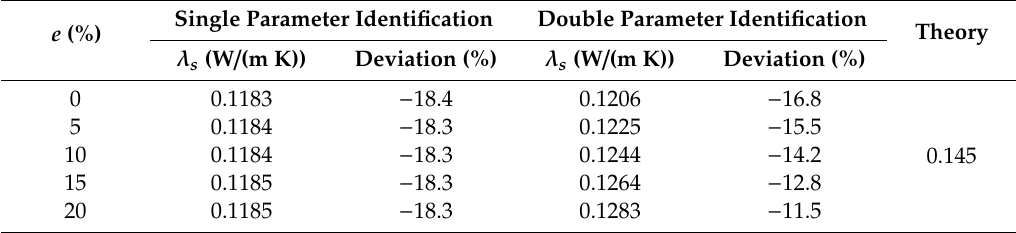
Table 4. Comparison between theoretical and identified values of thermal conductivity of nanometer-sized